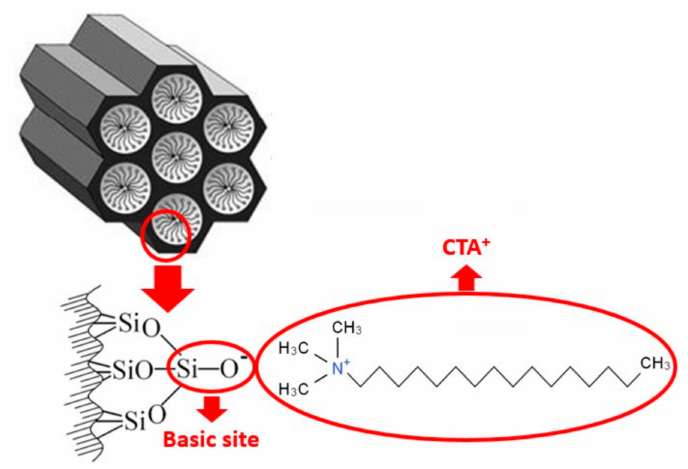
Figure 1. Schematic illustration of basic siloxy site generation in the MCM-41 structure by charge compensation with CTA + . (Modified from